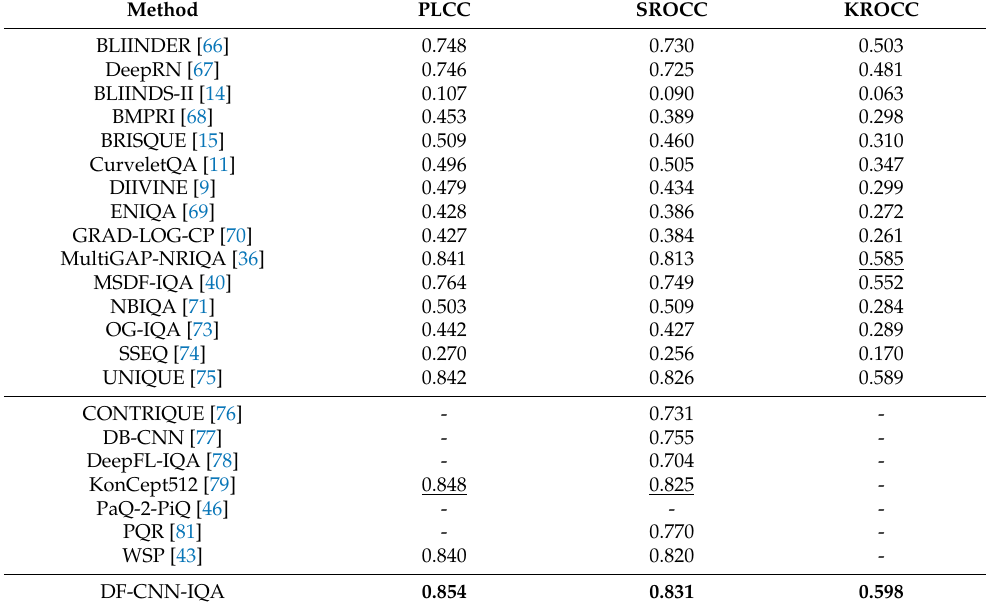
Table 8. Cross-database test. Methods were trained on KonIQ-10k [4] and tested on CLIVE [50]. The best results are typed in bold , and the second-best ones are underlined. We denoted by ‘-’ if the data were not